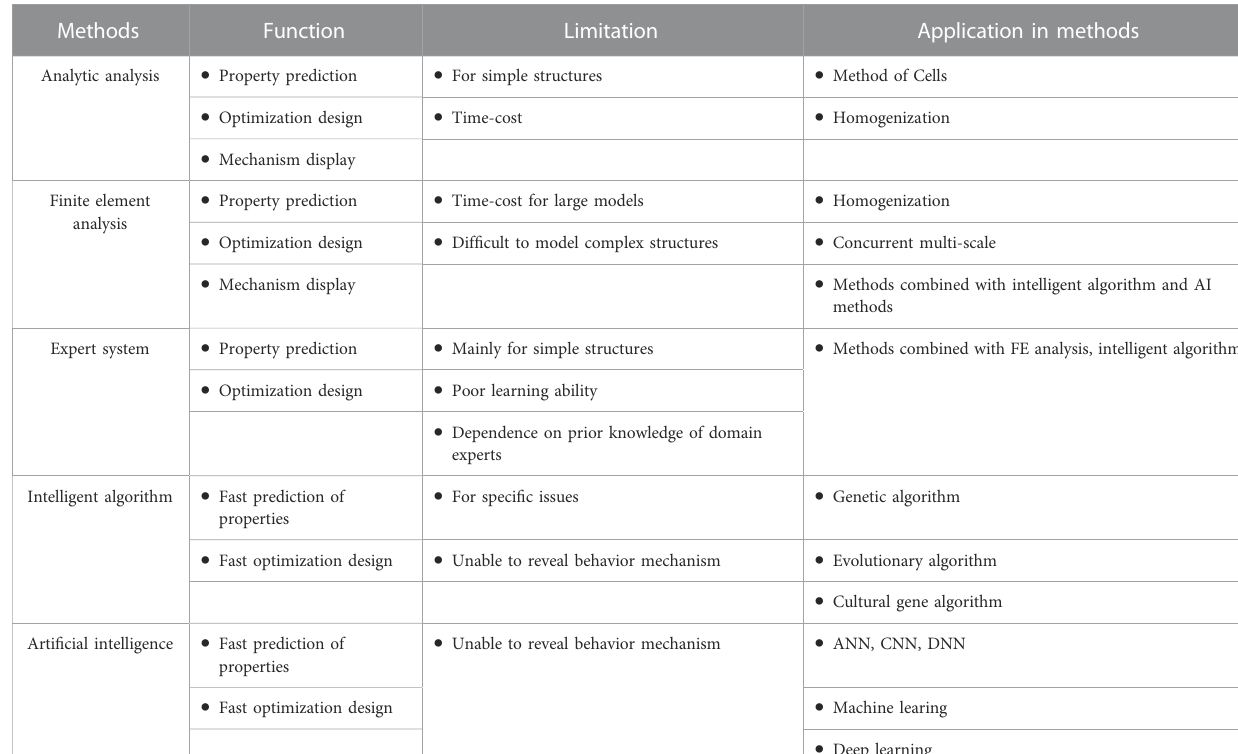
TABLE 2 Comparison of the traditional and intelligent methods for design of FRP